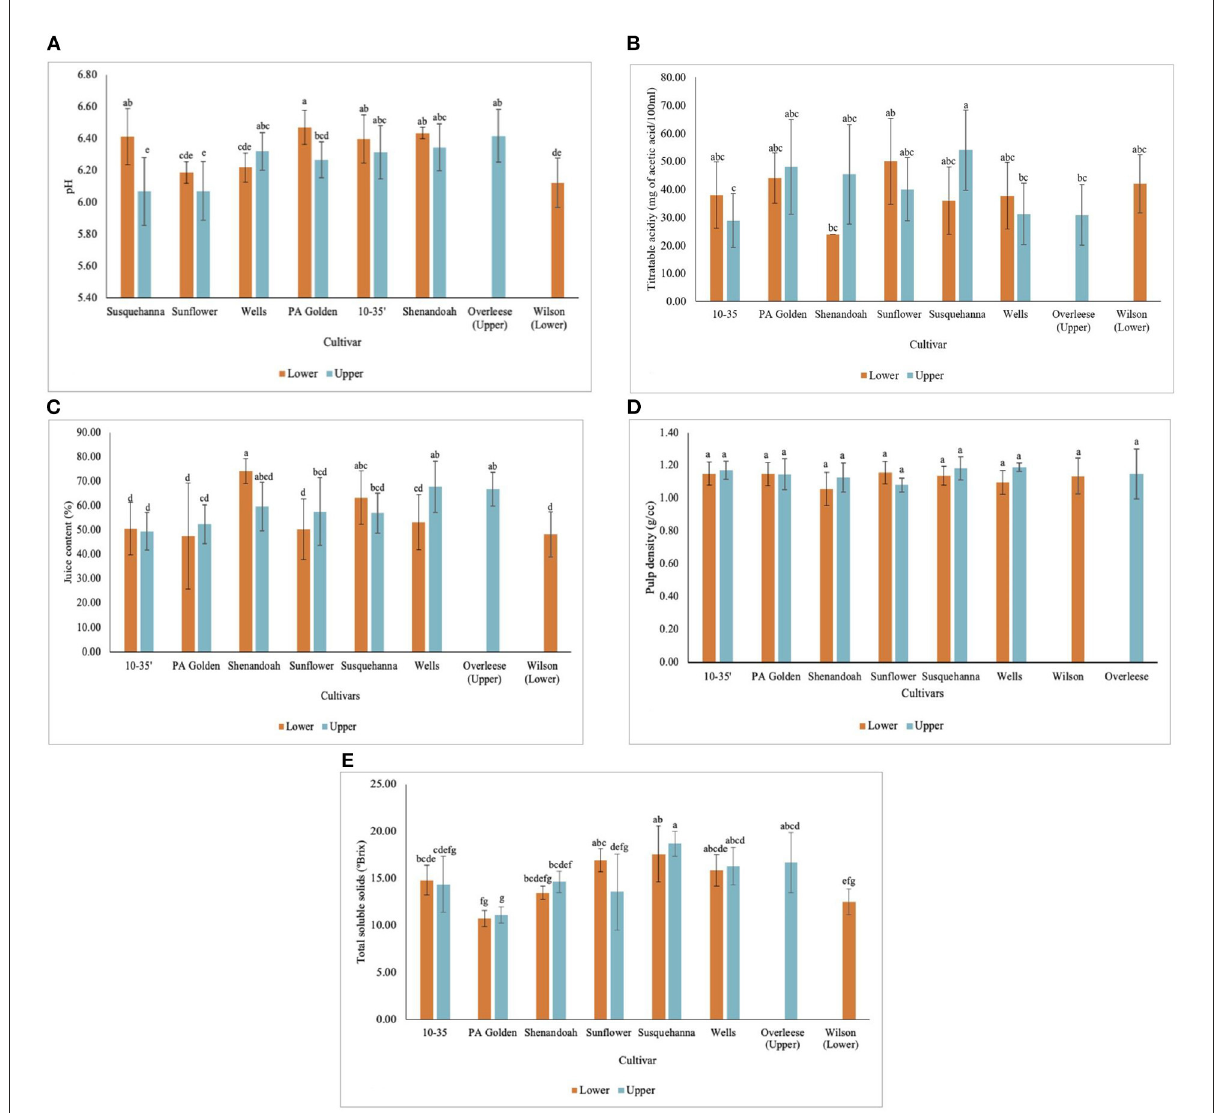
FIGURE4 Physicochemical properties of pawpaw fruits from different cultivars in the Lower and Upper orchards showing (A) pH, (B) titratable acidity, (C) juice content, (D) pulp density, and (E) total soluble solids